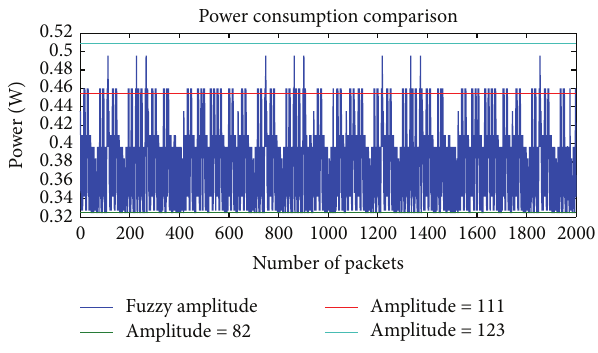
Figure 7: Power consumption comparison.